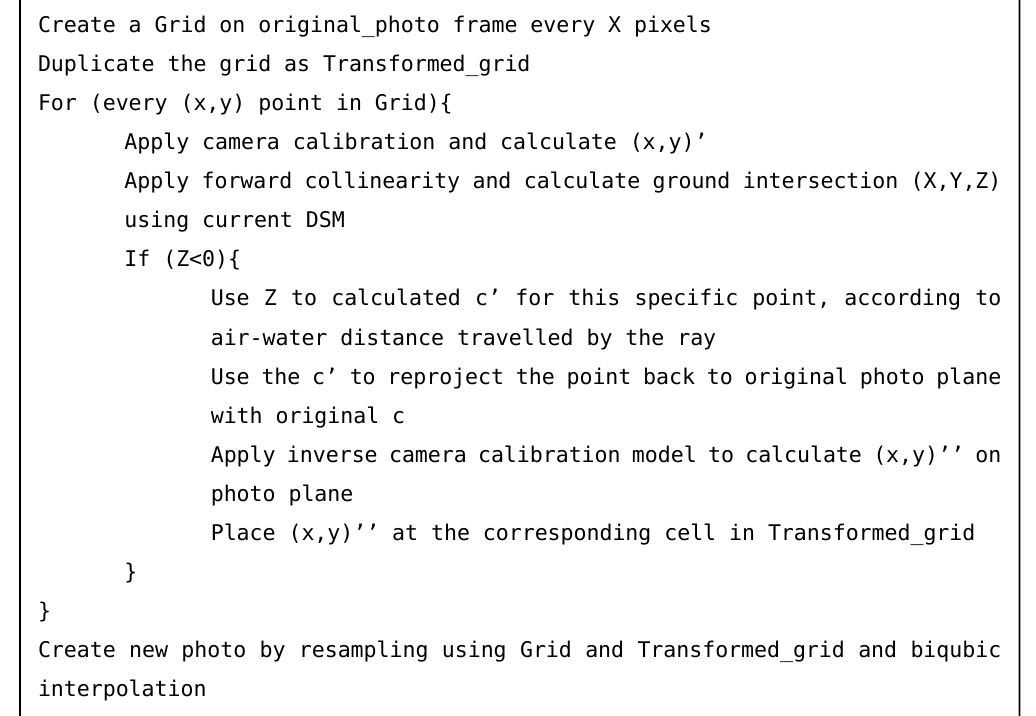
Figure 9. Pseudo ‐ code of photo transformation. Figure 9. Pseudo-code of photo